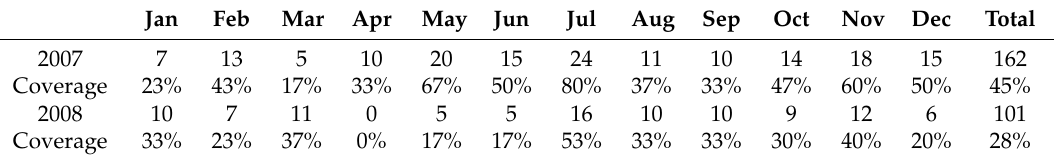
Table 2. Number of valid MODIS observations and coverage (%) in Deep Bay in 2007 and